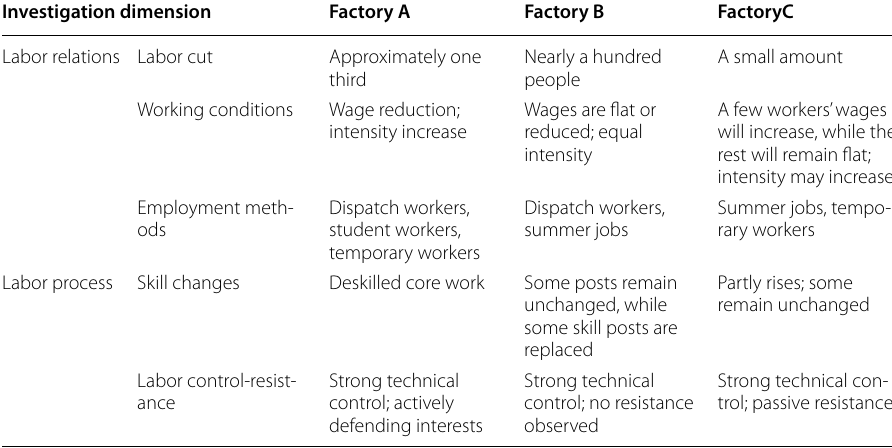
Table 1 Changes in the connotation of labor after technology upgrading Investigation